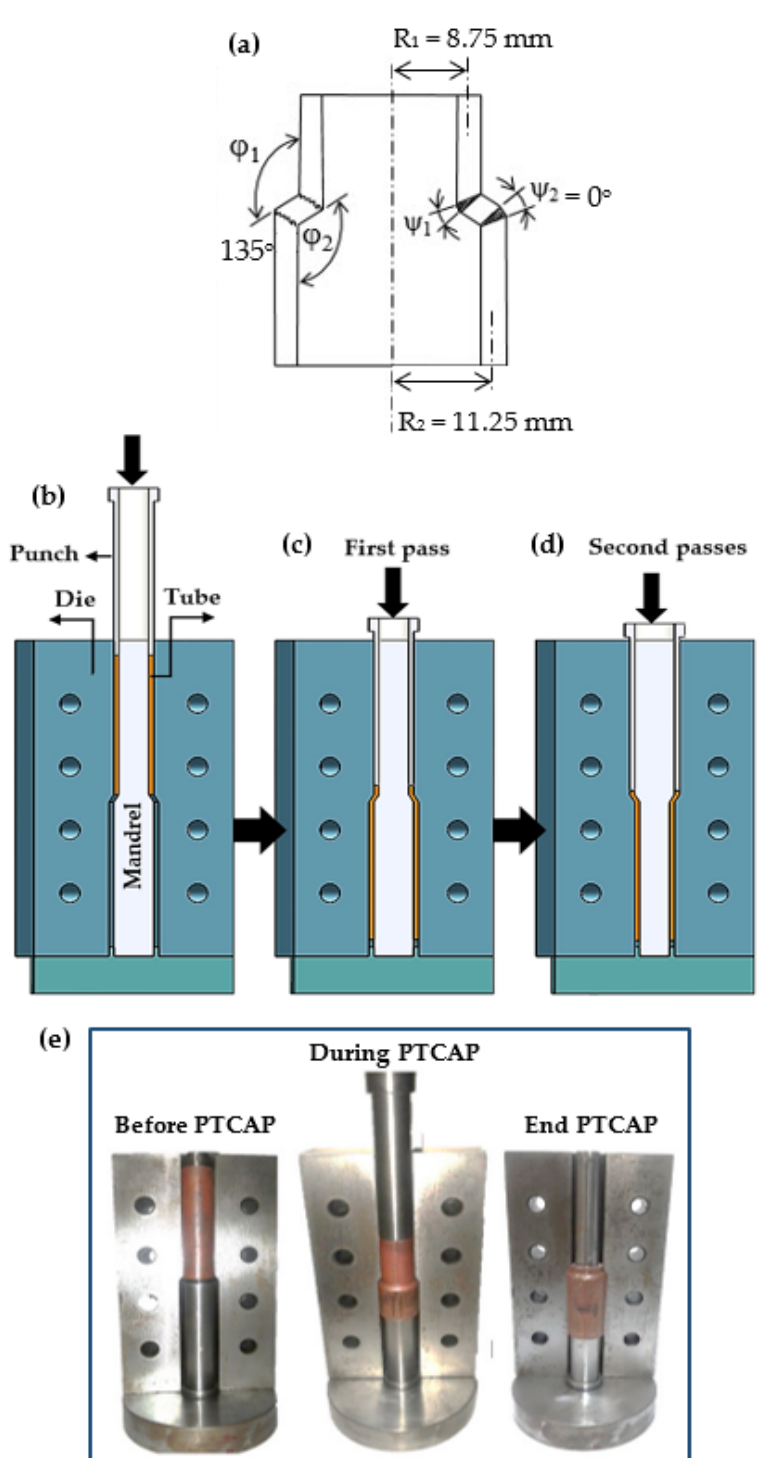
Figure 1. Schematic of the preparation: ( a ) PTCAP die working and geometry, ( b ) preparation setup, ( c ) first half of the cycle, ( d ) second half of the cycle, and ( e ) PTCAP process steps and sample shape.